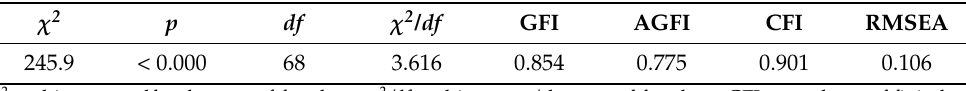
Table 5. Model fit indices.